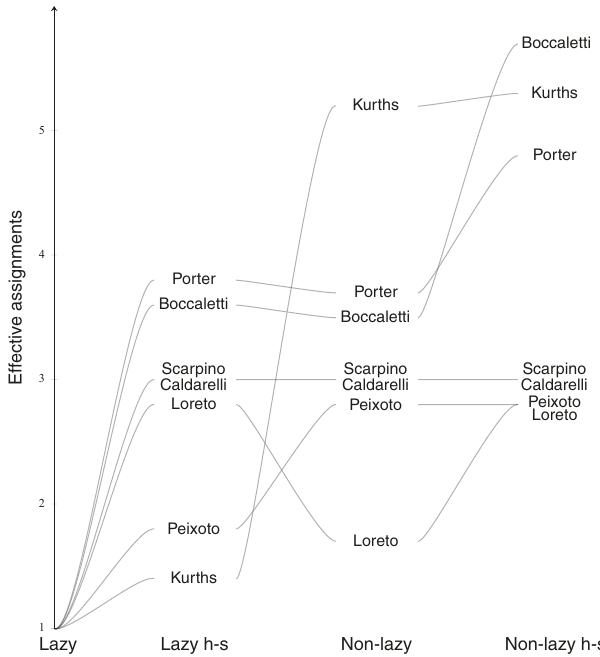
Fig. 5 The effect of random-walk model on researchers ’ effective module assignments. Authors in the collaboration hypergraph with the highest average effective number of assignments — the per-node module overlap measure in Eq. (25) — in the lazy and non-lazy multilayer representations (see Methods). Curves connect authors between different random-walk models. h-s